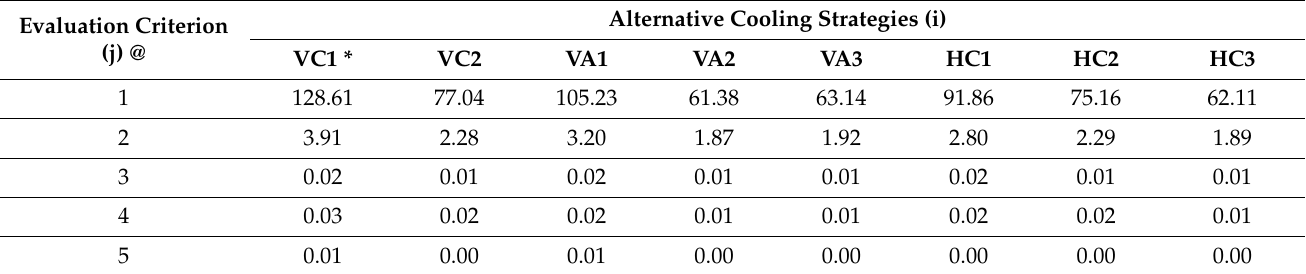
Table 5. The data of evaluation criterions corresponding to cooling strategies for temperate continental climate. Evaluation